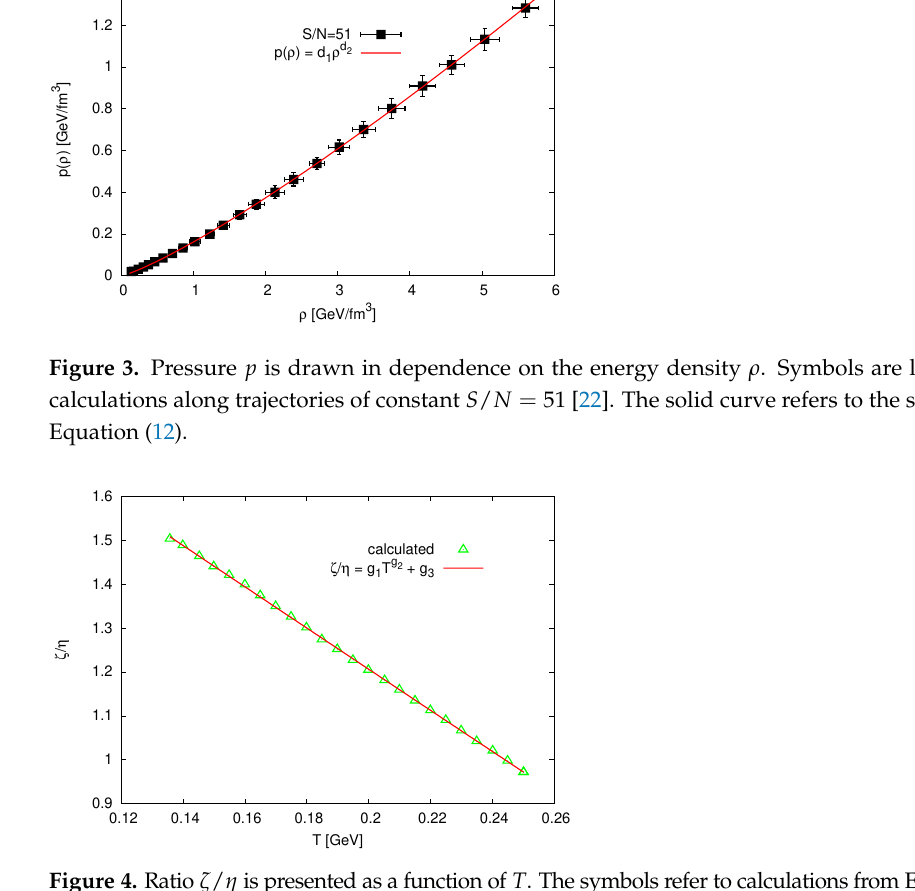
Figure 4. Ratio ζ / η is presented as a function of T . The symbols refer to calculations from Equation (14) and Ref. [25], while the solid curve shows Equation (15).